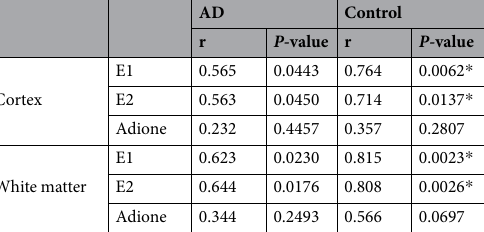
Table 2. Correlation coefficient (r) between body mass index and concentrations of sex steroid hormones in the cortex and white matter of the frontal lobe among Alzheimer’s disease and control groups. * Significant; P < 0.05/3 (Bonferroni adjustment). AD, Alzheimer’s disease; E1, estrone; E2, estradiol; Adione, androstenedione.